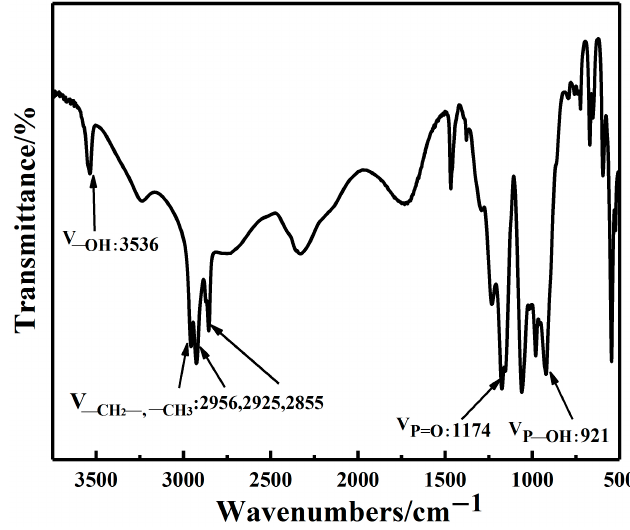
at around 1174 cm − 1 and 921 cm − 1 are separately assigned to stretching vibration bands of Figure 7. 1 H NMR and 31 P NMR of HOBA ( a ): 1 H NMR; ( b ) 31 P NMR. Figure 7. 1 H NMR and 31 P NMR of HOBA ( a ): 1 H NMR; ( b ) 31 P NMR. P=O and P–OH [32].